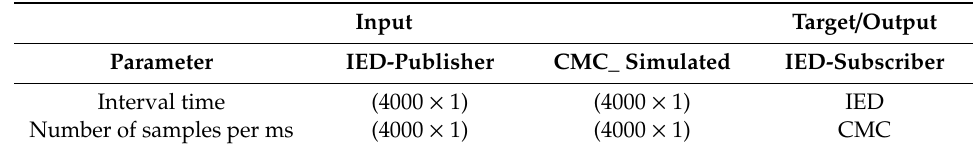
Figure 17. Data preparation of parameters. Table 6. Data preparation and input array